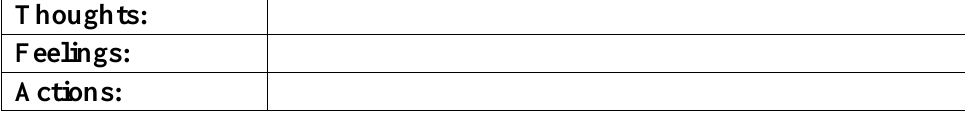
Figure 3.1 – Example Tactical